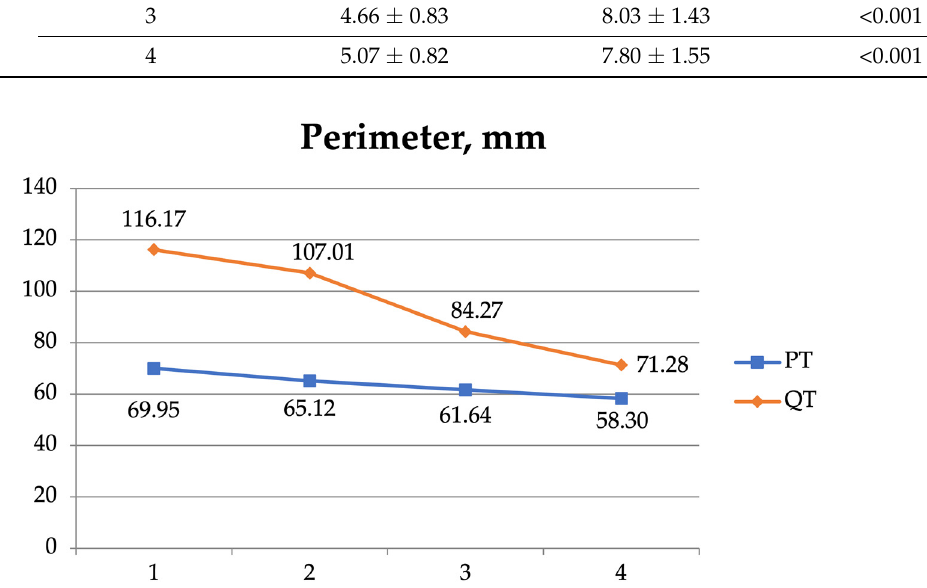
Figure 4. The perimeter of the patellar tendon (PT) and the quadriceps tendon (QT) at the 4 measurement sites.